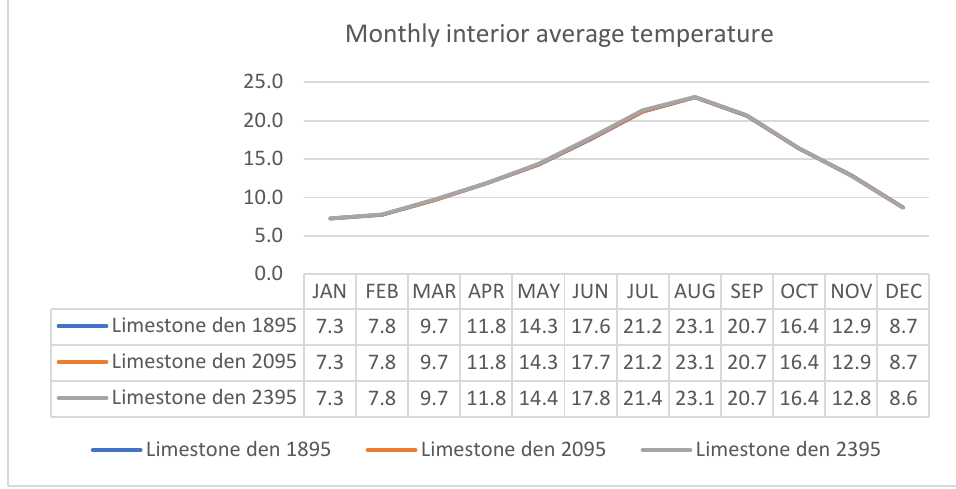
Figure 5. Monthly interior average temperature.